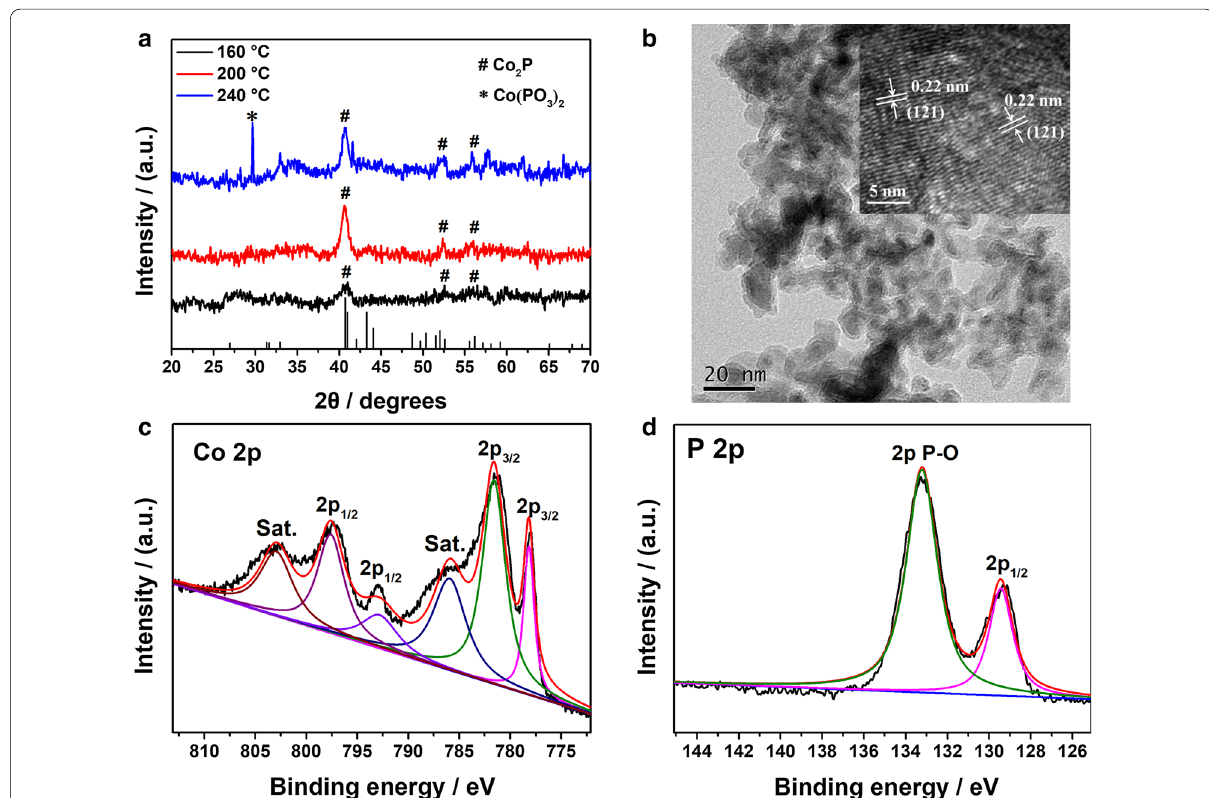
Fig. 1 a XRD patterns of Co 2 P NPs prepared at different temperatures for 12 h. b Transmission electron microscopic image and high-resolution transmission electron microscopic image (inset) of Co 2 P NPs. XPS spectra of Co 2 P in the c Co 2 p region and d P 2 p